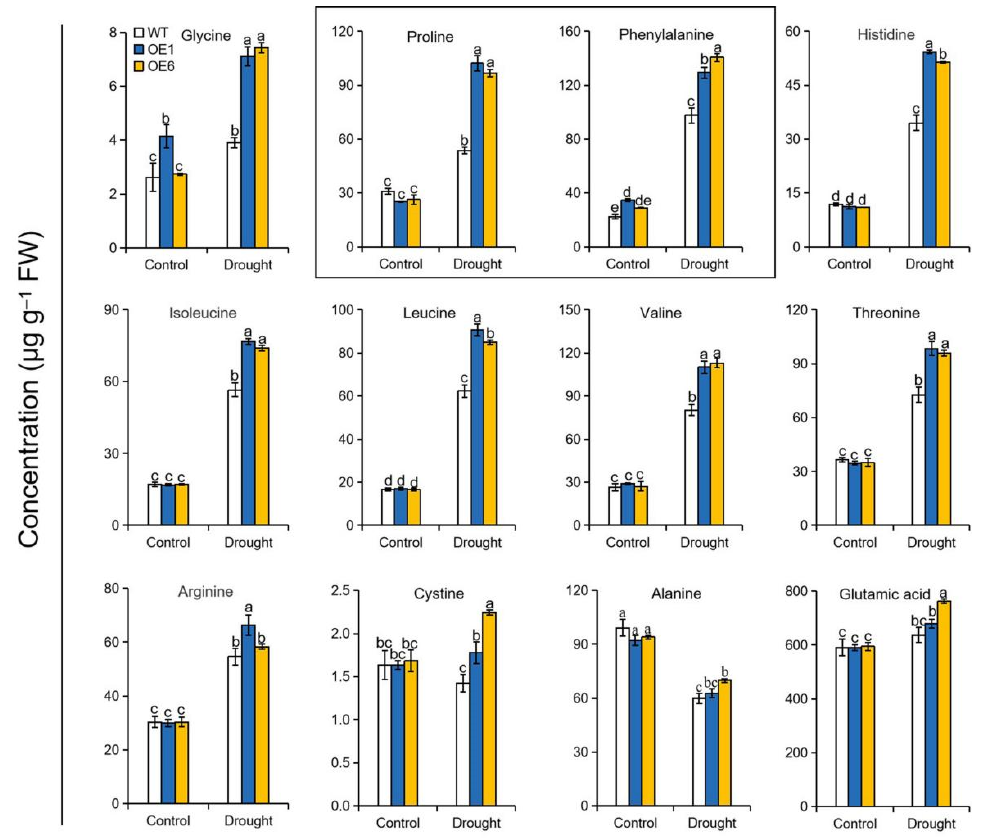
Figure 5. Accumulation of amino acids in the leaves of WT and MdATG8i OE plants under drought conditions. FW, fresh weight. The data are presented as means ± SD of three replicates. Values with different letters are significantly different ( p < 0.05, Tukey’s multiple range test).